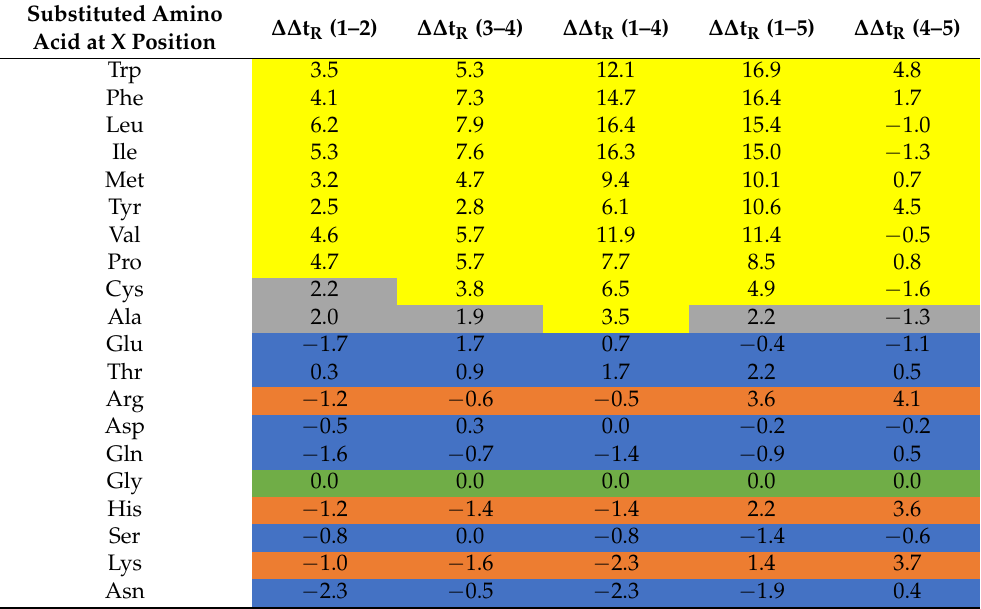
Table 15. Hydrophobicity differences among the peptide models [31]. Substituted